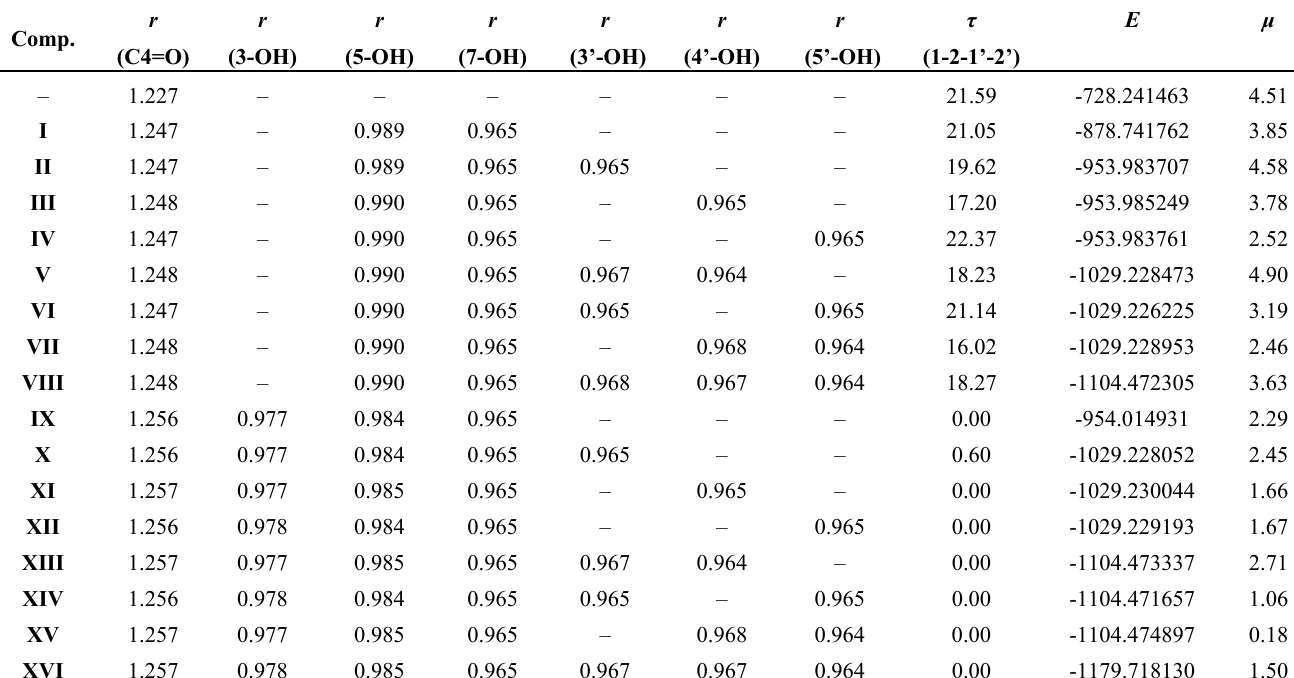
Table 2. Main geometrical and energetic parameters of the studied flavonoids in gas phase calculated at B3LYP/6-311++G** theoretical level. Atom numbering as in Figure 1. Interatomic distances, r , in Å; dihedral angles, τ , in deg; energy, E , in a.u.; dipole moment, μ , in D